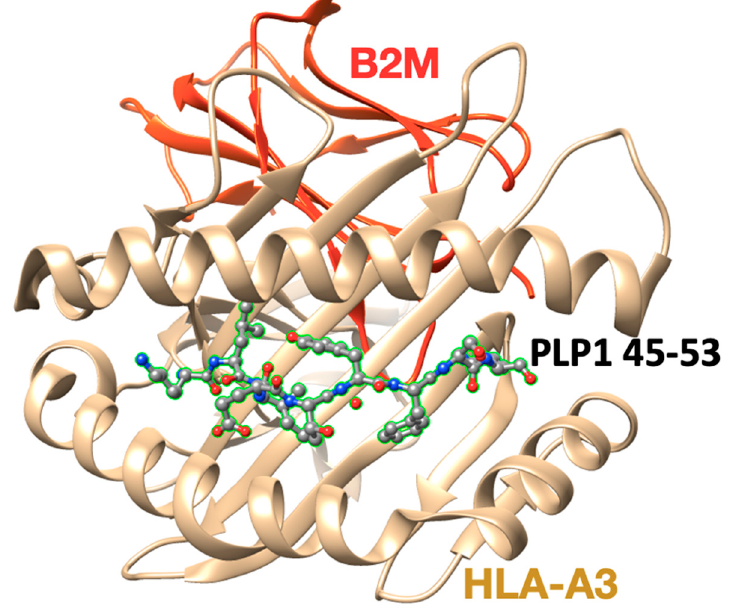
Figure 4. The X-ray crystal structure (pdb: 2XPG) of the human major histocompatibility (MHC) class I molecule HLA-A*0301 (HLA-A3) in complex with a PLP 45–53